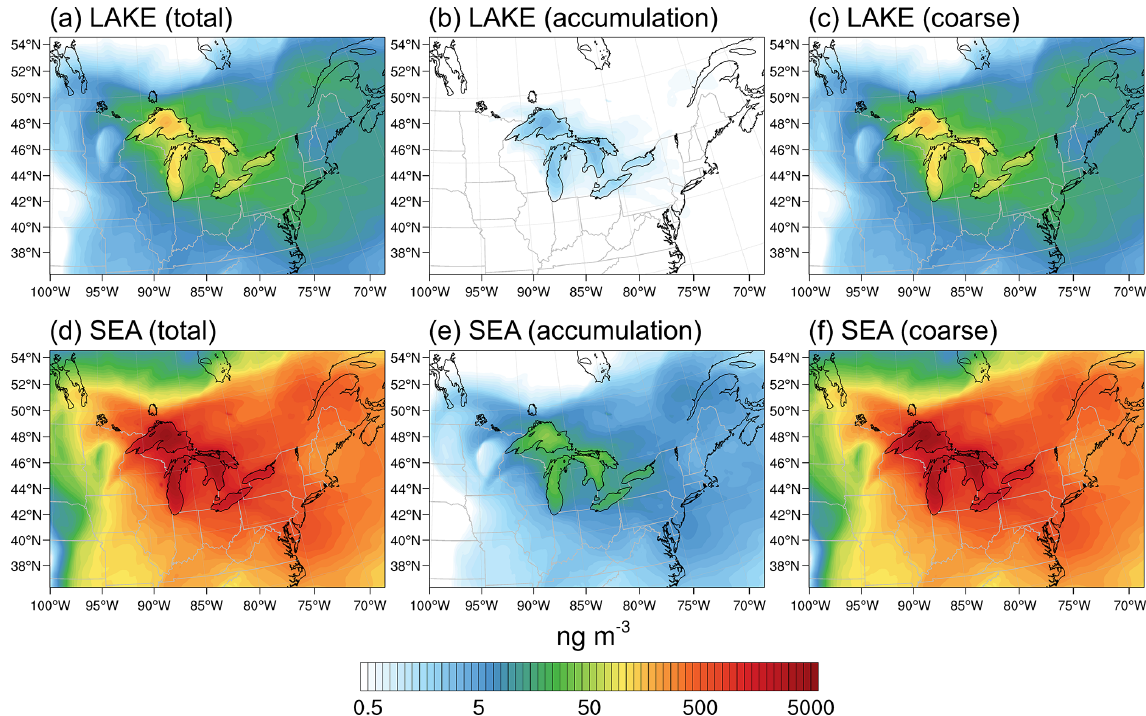
Figure 9. Average (10–30 November 2016) total, accumulation-mode, and coarse-mode surface layer aerosol mass concentrations of parti- cles emitted from the Great Lakes surface in the (a–c) LAKE and (d–f) SEA